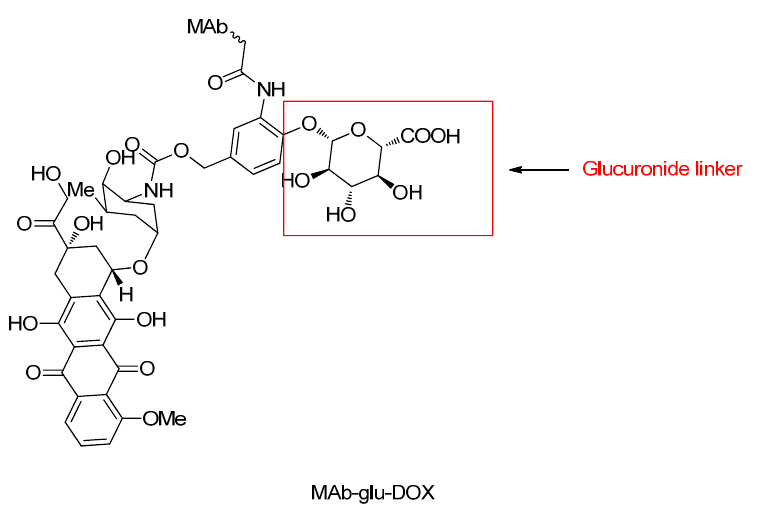
Figure 13. The structural formula of MAb-glu-DOX. Adapted from reference [79].